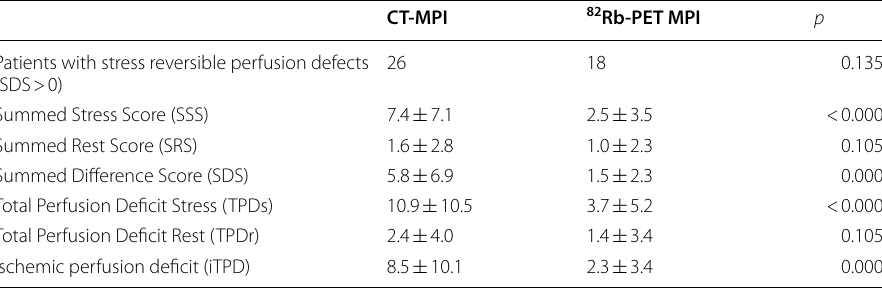
Table 4 Comparison of CT-MPI and 82 Rb PET MPI